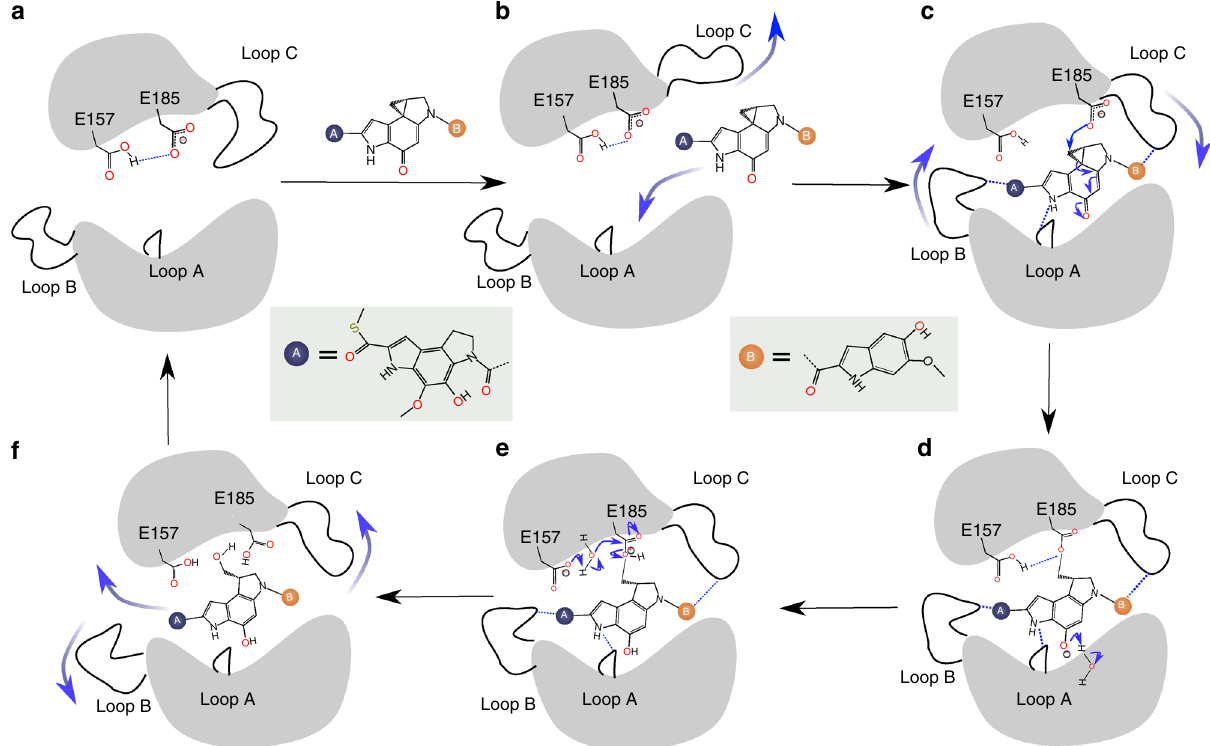
Fig. 3 The catalytic mechanism of CCHs. a In an apo CCH, the three loops (loop A, B, and C) next to the catalytic pocket are very fl exible and the size of the pocket can be fl uctuated to a large extent. E157 is protonated, whereas E185 is deprotonated. b The entry of substrate into the CCH leads to the outward shift of loop C, resulting in a large space in the binding pocket. This facilitates the substrate molecule entering the catalytic region. c After substrate situating at the catalytic site and in an activated binding mode. E185 acts as a nucleophile, attacking the methylene group in the cyclopropyl ring. This leads to transformation of the quinone moiety into a deprotonated phenol. d The deprotonated phenol moiety of the transitional substrate acquires a proton from a water molecule. e With the assistance of E157, the transitional state is hydrolyzed by a water molecule. f Finally, with the outward fl uctuations of loop B and loop C, the product leaves catalytic pocket. The E185 residue returns to its deprotonated